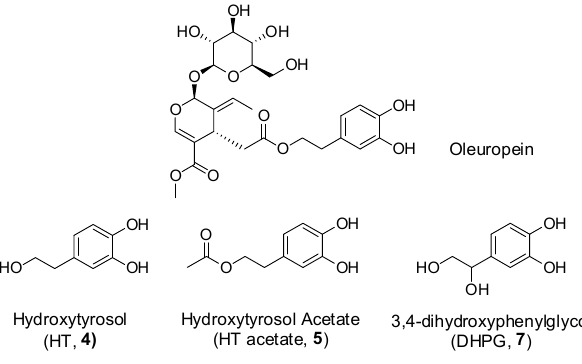
Figure 1. Major polyphenols of olive tree.